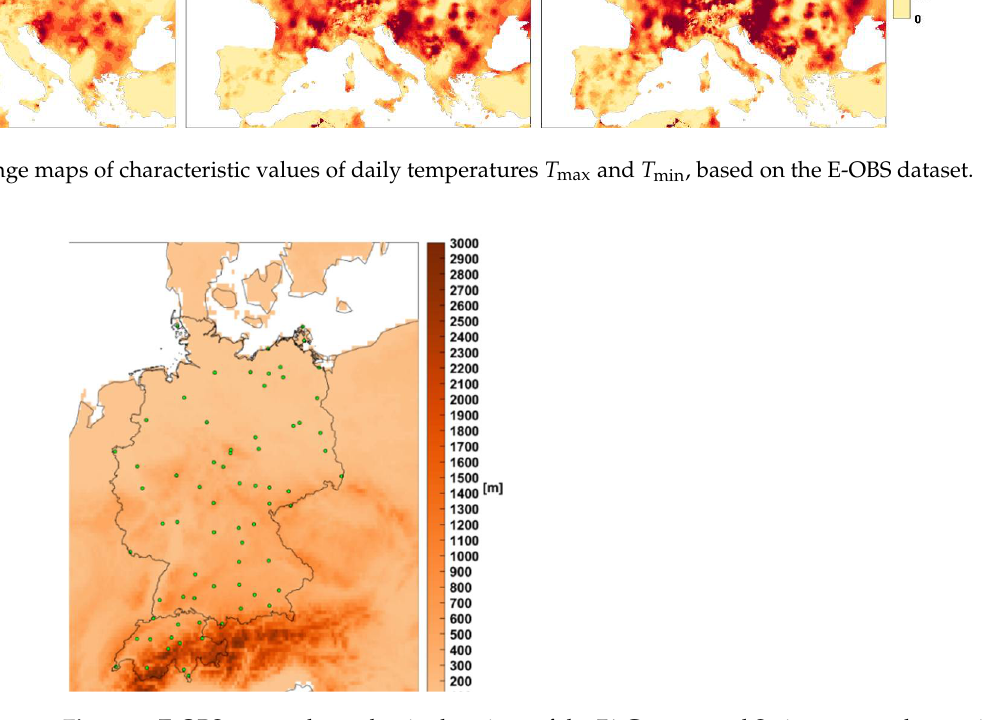
Figure 8. E-OBS orography and point locations of the 71 German and Swiss test weather stations.